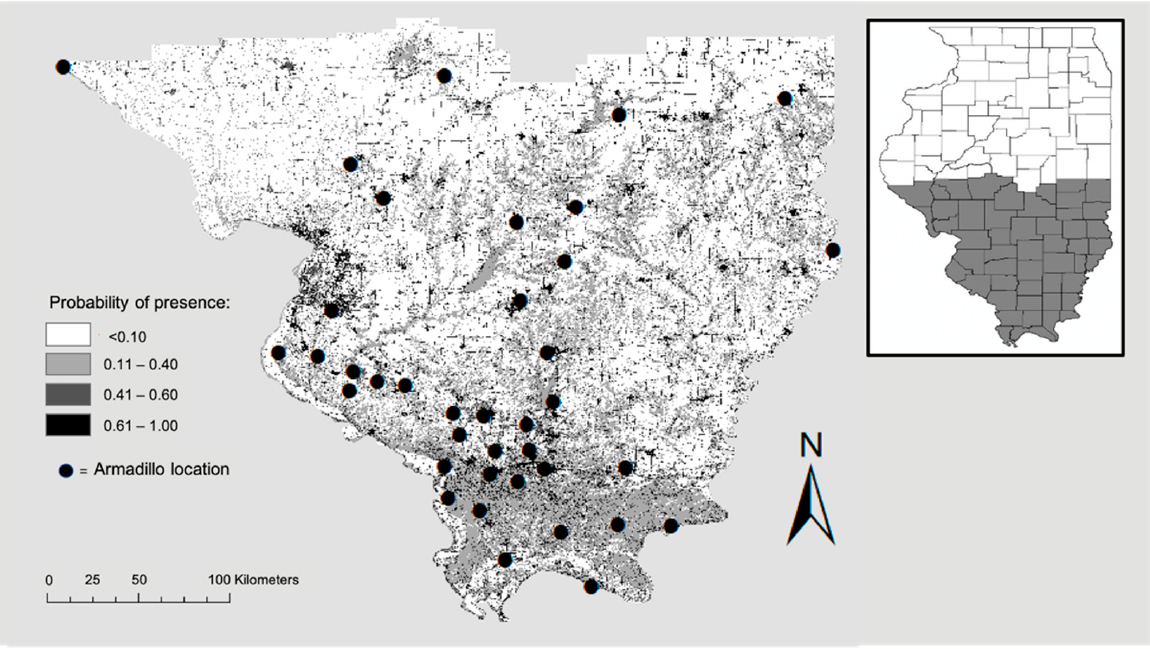
Figure 2. Potential distribution of nine-banded armadillos in southern Illinois during 2016–2020. Map shows probability of presence from low (0.0) to high (1.0) and armadillo presence locations used to develop the model. Probability of presence was higher in contiguous patches of forested land and around roads and waterways.